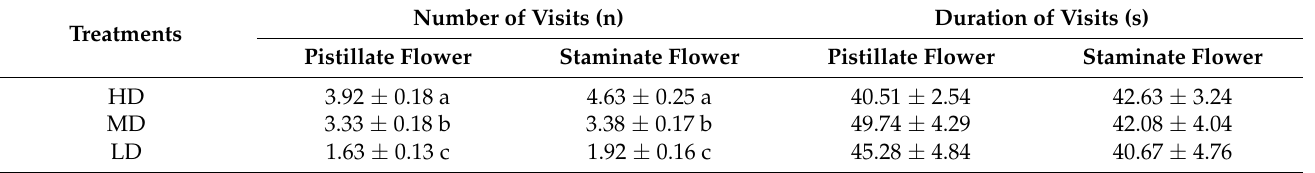
Different lowercase letters in the same column indicate significant differences among treatments (release densities). Mean separation by Tukey’s test at p <